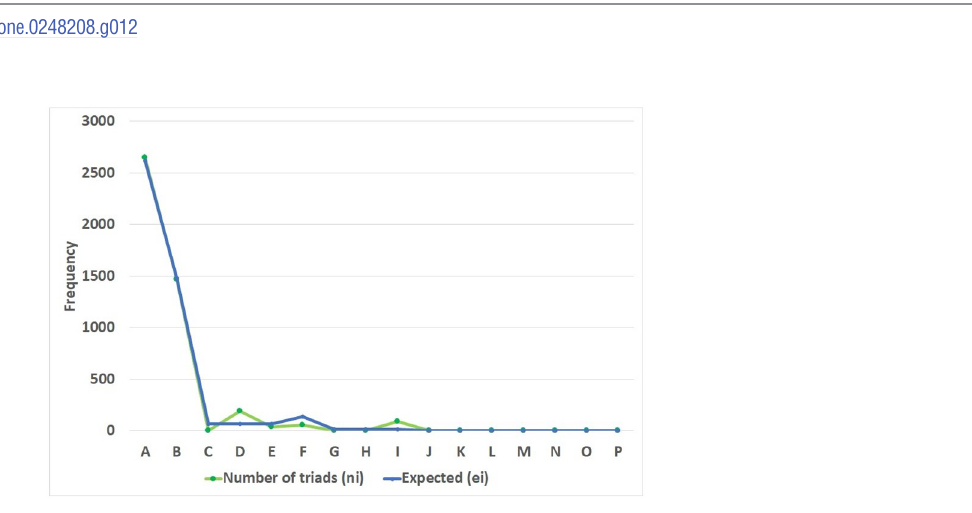
Fig 13. Types of motifs of size three in a random